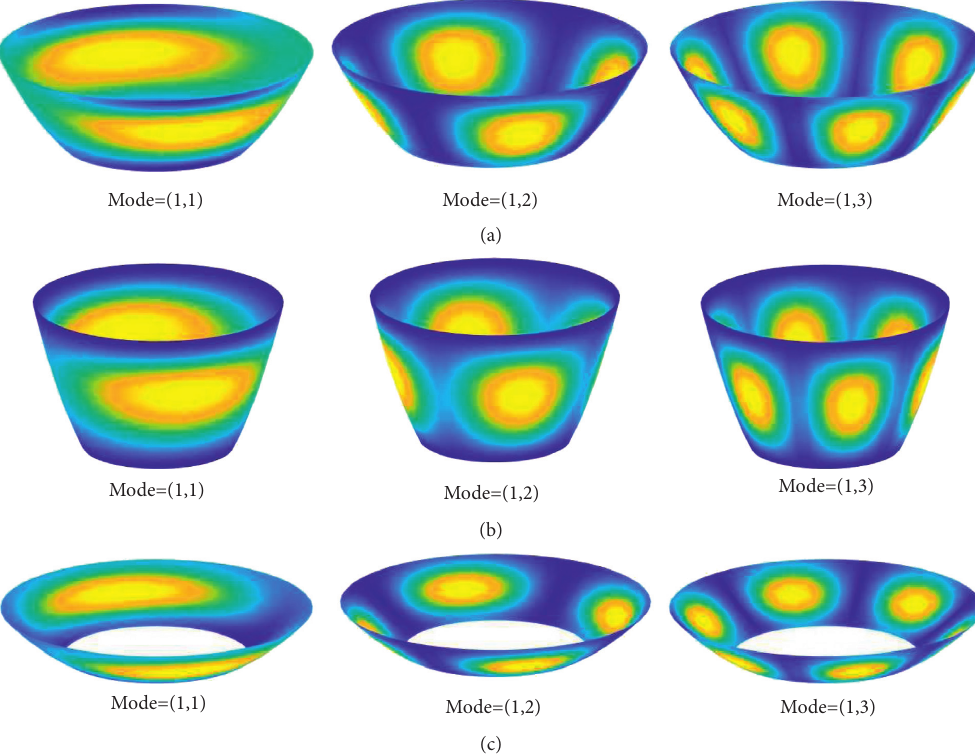
Figure 7: Several typical mode shapes for Sandwich FGP paraboloidal shell. (a) Paraboloidal shell ( k � 1) with E1-E1 boundary conditions. (b) Paraboloidal shell ( k � 2) with E2-E2 boundary conditions. (c) Paraboloidal shell ( k � 3) with E3-E3 boundary conditions.